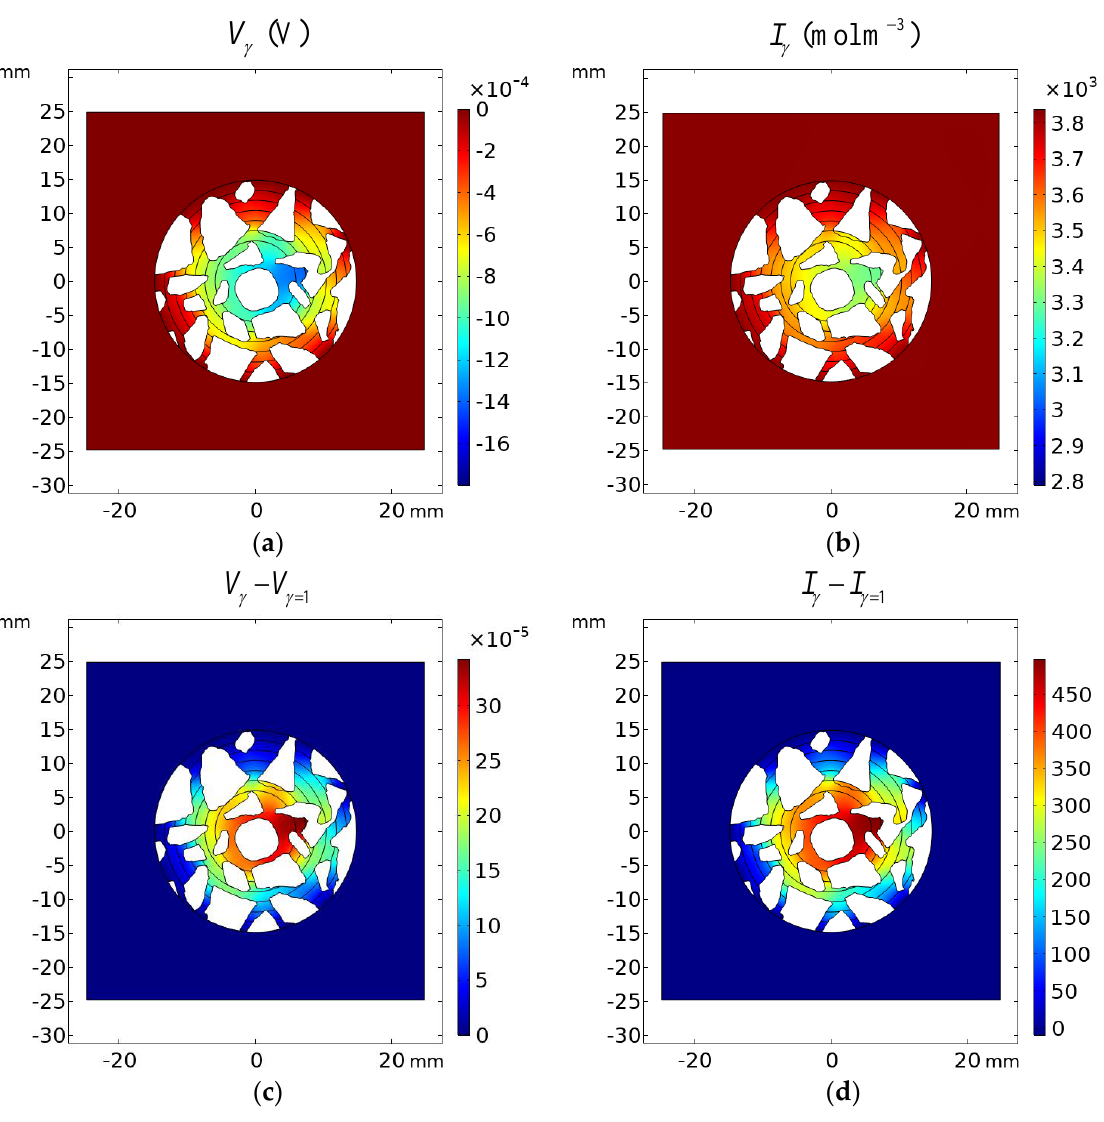
Figure 20. Results of calculations: ( a ) potential distribution V γ and ( b ) ionic strength I in the cement sample after 1200 h of immersion in 20% NaCl water solution assuming the Pitzer activity model; ( c ) deviation of the Pitzer activity model solution from the ideal solution approximation ( γ = 1) of potential V γ − V γ = 1 and ( d ) ionic strength I γ − I γ = 1 .